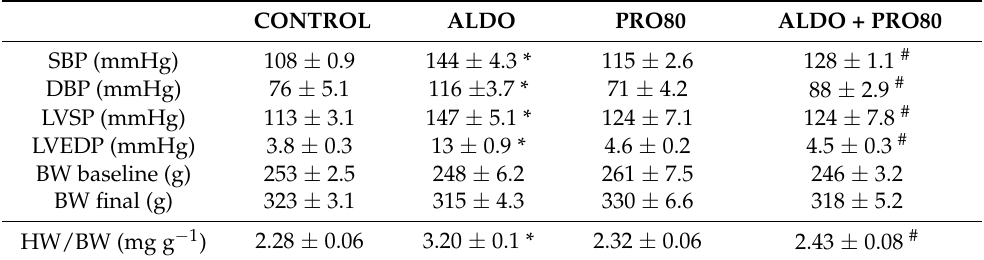
Table 1. Hemodynamic parameters, body weight and relative heart